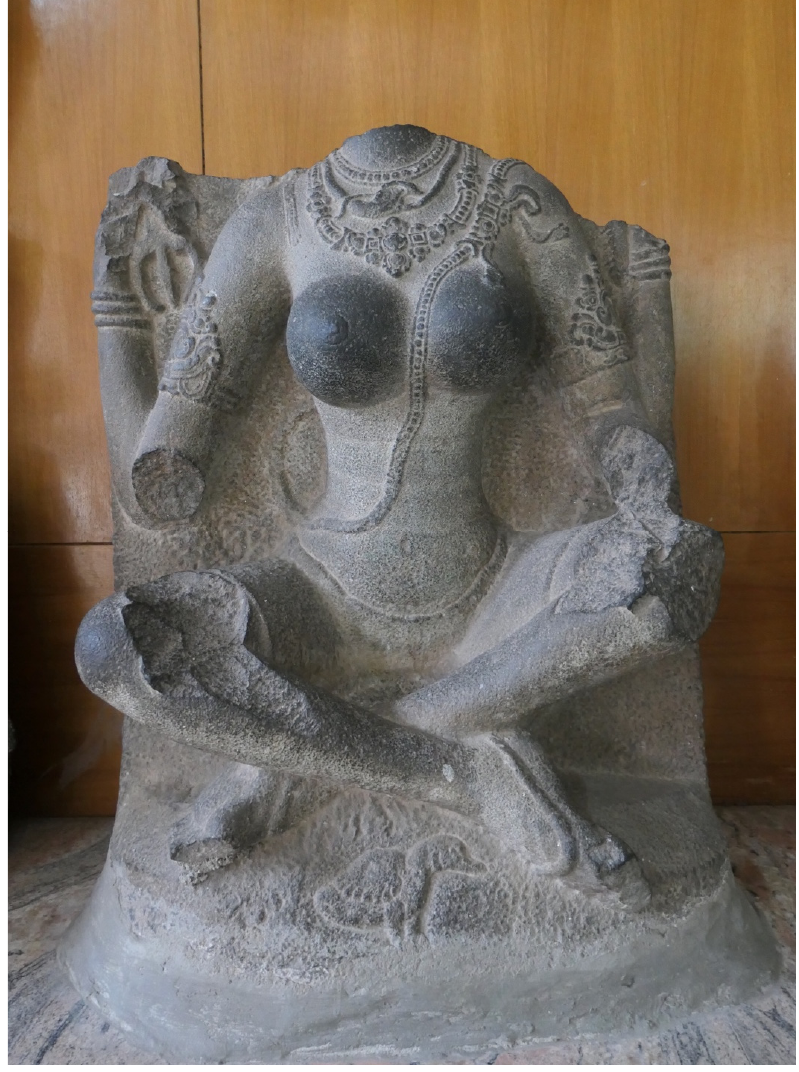
Figure 16. Yogini, Tamil Nadu, late 9th–mid-10th century. Government Museum, Chennai, 71-37. Photograph by Katherine E. Kasdorf.